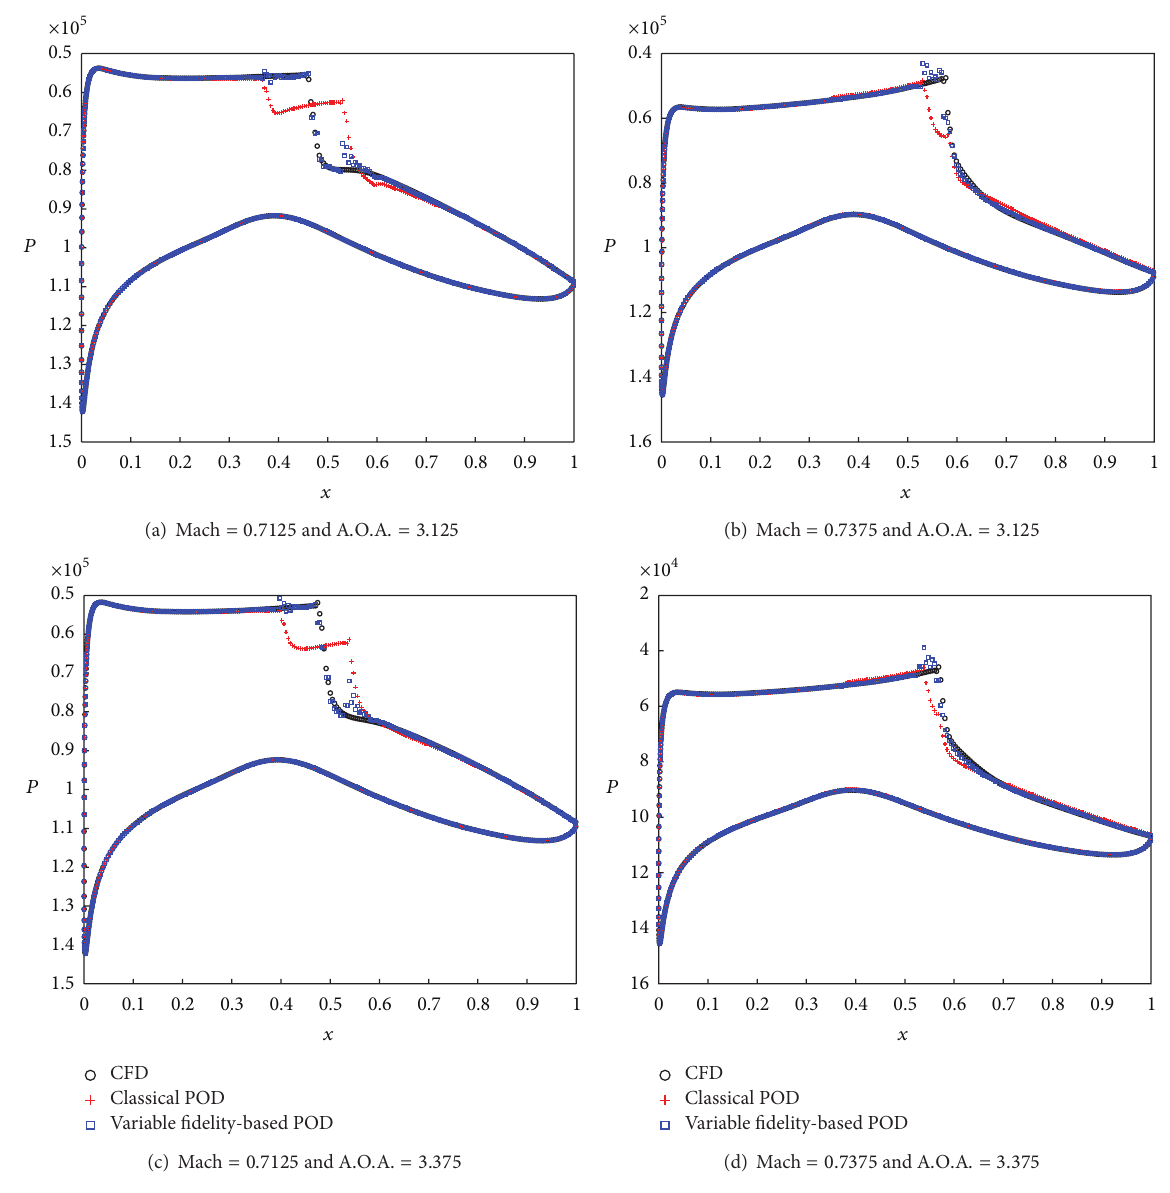
Figure 9: Pressure distribution over cord line. Table 1: Comparison of the global error (GE) and airfoil error (AE) on pressure for the classical POD (CL-POD) and the variable fidelity POD (VF-POD)